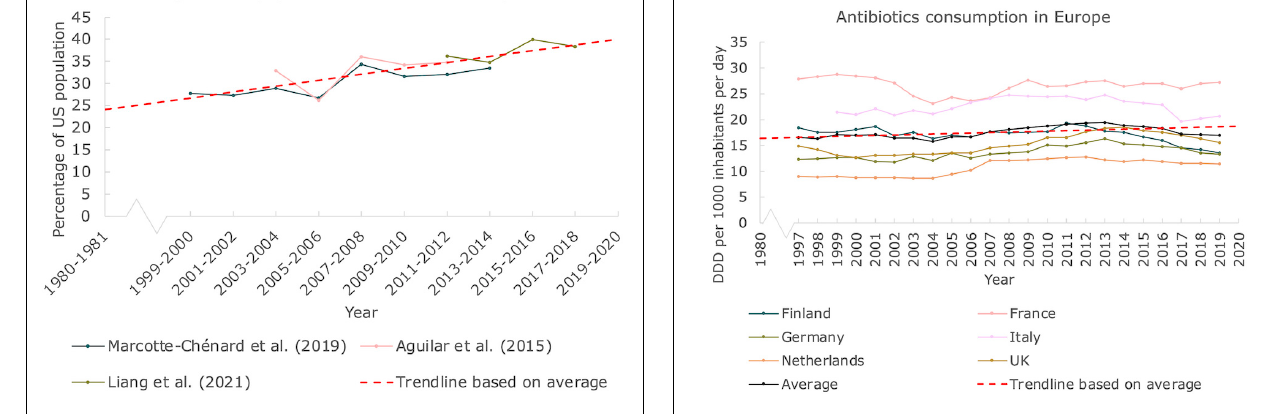
FIGURE 2 | Prevalence of MetS in the United States. The percentage of people in the United States suffering from at least 3 indications responsible for MetS. Data derived from 3 articles based on NHANES by CDC. A linear trendline was added as guide to the eye (Mann Kendall Trend test: P <